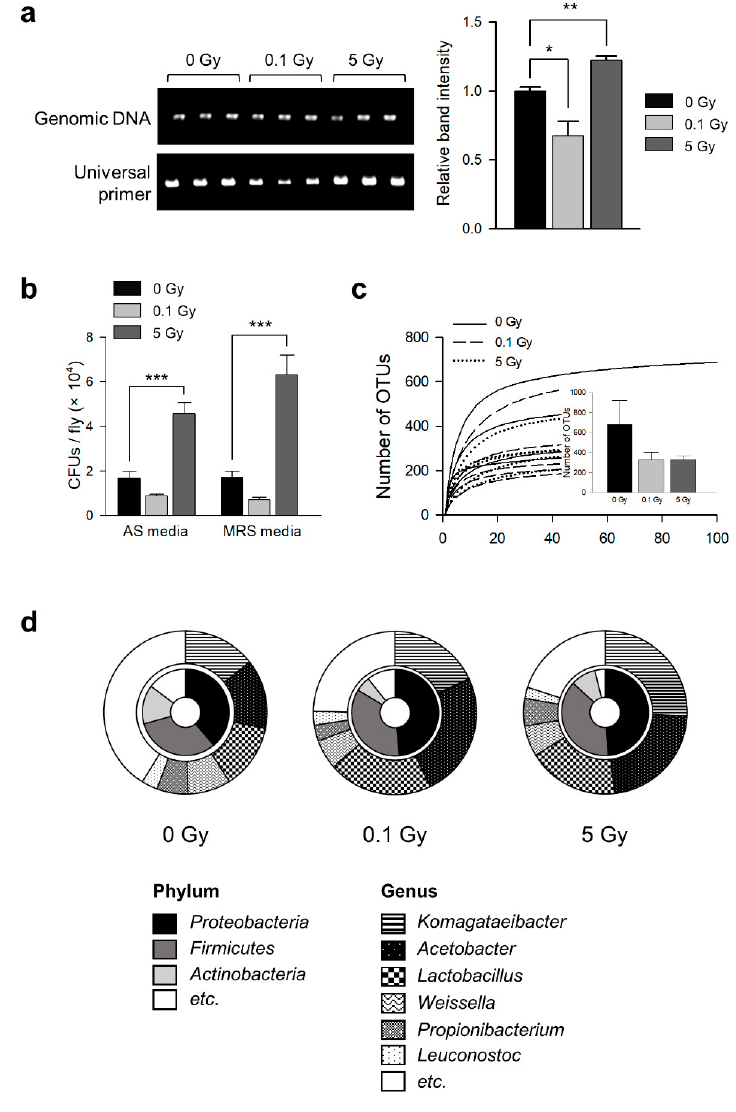
Figure 1. Microbial floral changes in D . melanogaster induced by γ -ray irradiation. ( a ) PCR assay of microbial 16S rRNA amplified gene using a universal primer (27F, 1492R). Microbial 16S rRNA gene sequences were amplified from the genomic DNA extracted from irradiated flies. ANOVA with Tukey’s post hoc test, * p < 0.05, ** p < 0.005. ( b ) The total number of CFUs from irradiated flies in